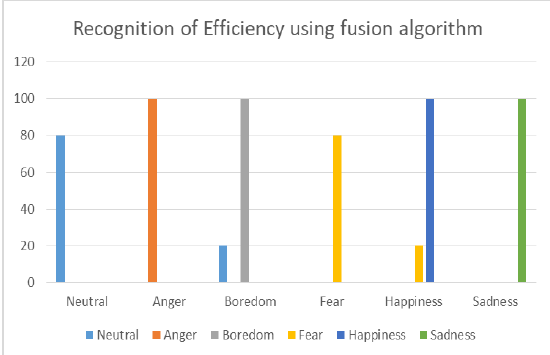
Fig 9. Comparison of % recognition for feature extraction